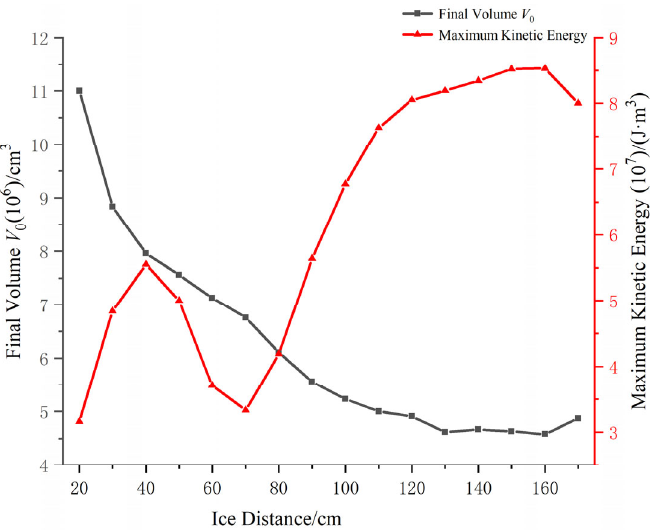
Figure 11. Relationship between ice distance, final volume, and maximum kinetic energy.